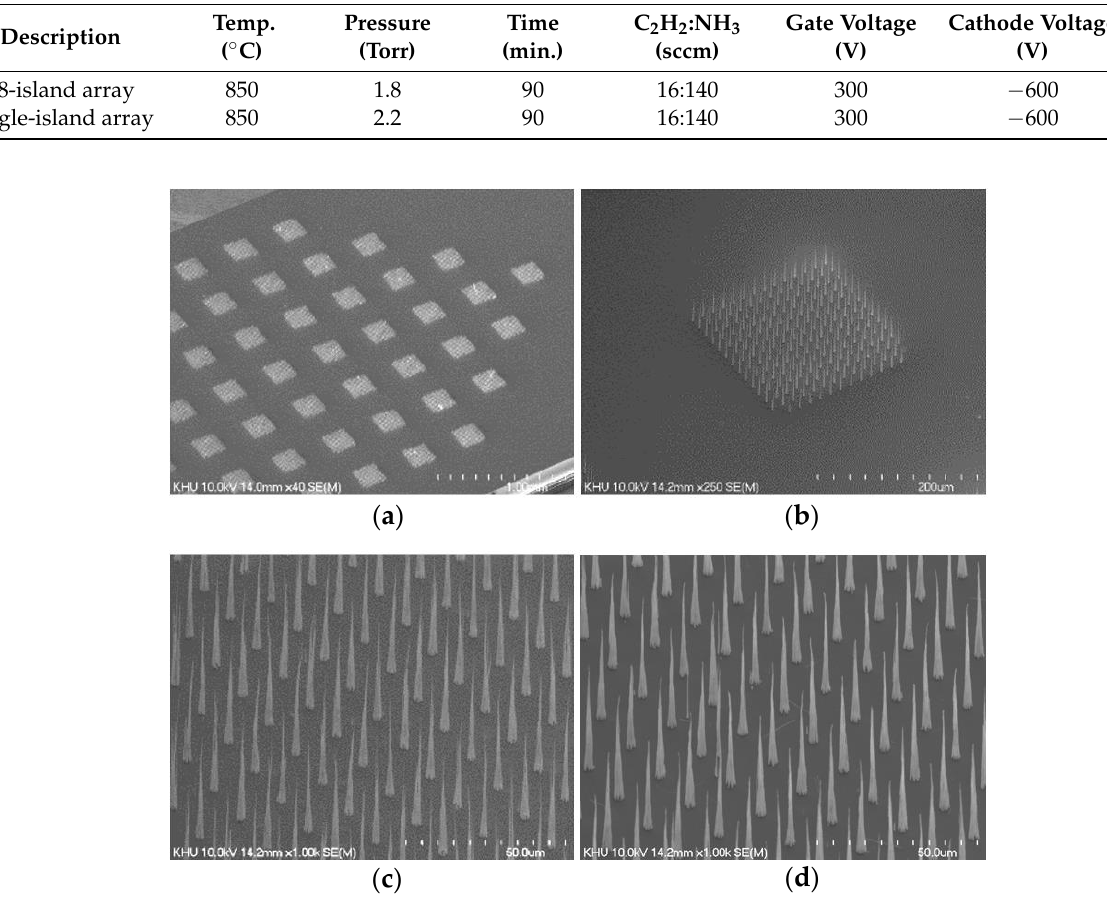
Figure 2. SEM images of the two groups of emitter arrays: ( a ) partial image of 88-emitter array and ( b ) single-emitter array; ( c , d ) represent magnified SEM images of ( a , b ) at the same magnification of 1000. The side length of the squares in ( a , b ) is 200 μm.